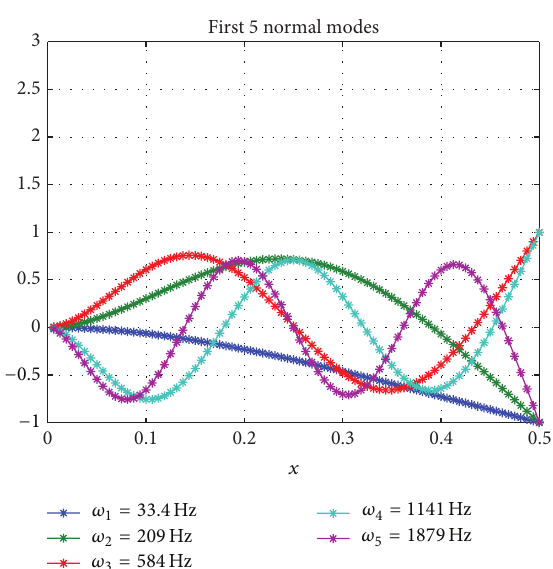
Figure 2: First five normal modes of a cantilever beam with the corresponding natural